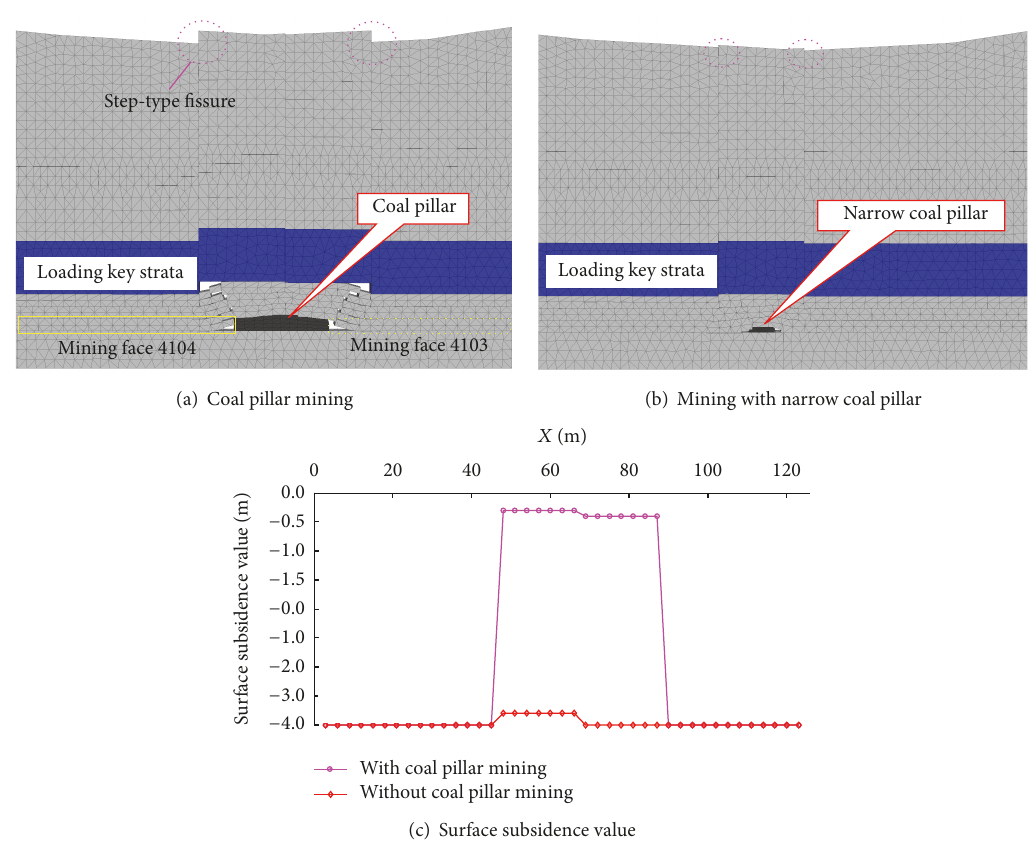
Figure 13: Morphological development of ground fissures under conditions of coal pillar mining and mining with narrow and small coal